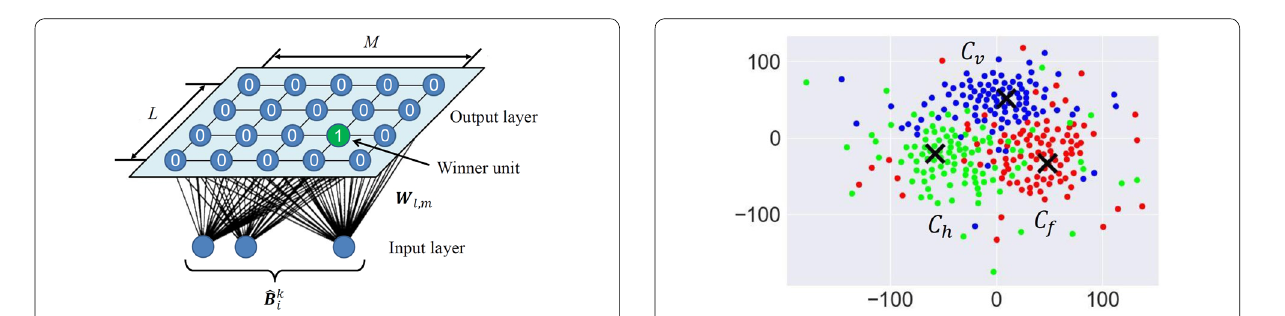
Fig. 14 Conversion into the 1‑of‑K vector using SOM